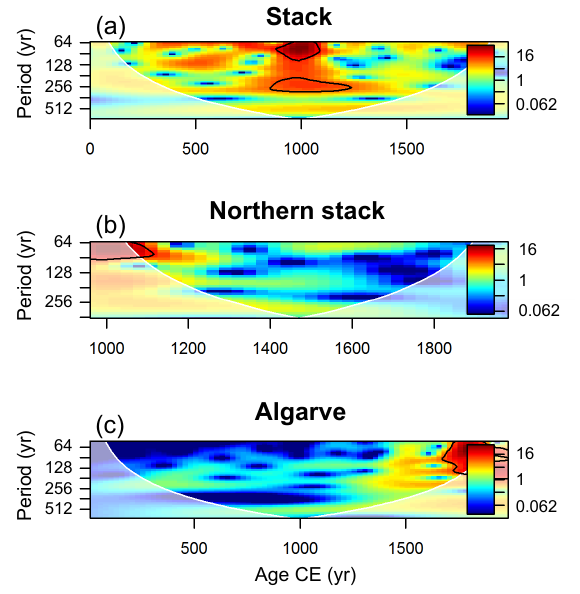
Figure 7. The continuous wavelet power spectrum of the [ n -alk] stack record (a) ; the north [ n -alk] stack (b) and the Algarve [ n -alk] record (c) . The thick black contour designates the 95% confidence level, and the lighter shaded area represents the cone of influence (COI) where edge effects might distort the